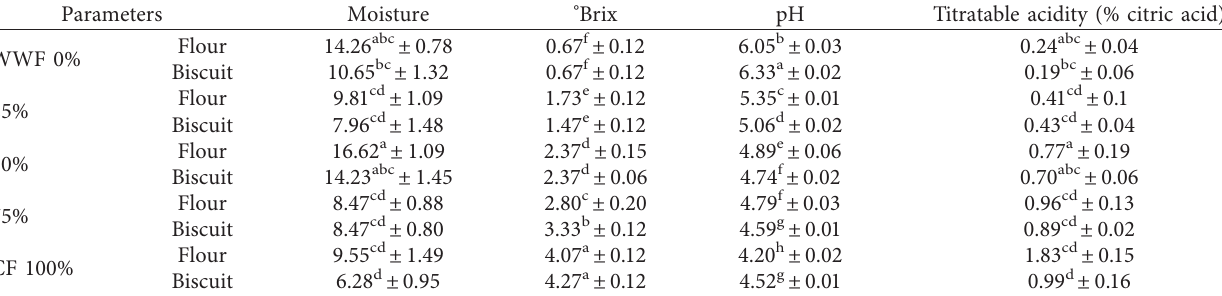
Table 3: Physicochemical characteristics in flour and biscuit of composite samples.